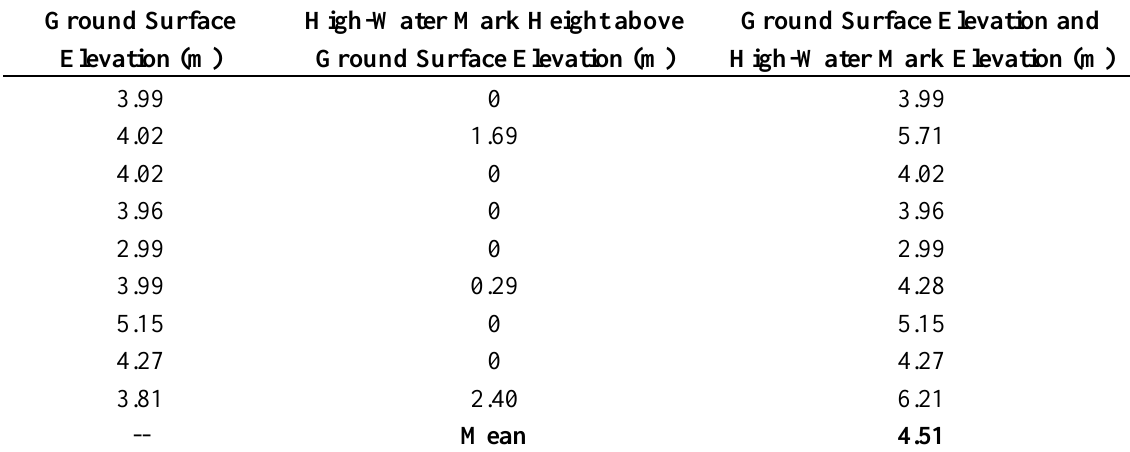
Figure 2. U.S. Geological Survey high-water marks collected in cooperation with the Federal Emergency Management Agency on the southern part of Staten Island, New York. We used the mean of GPS survey elevation values and high-water mark height above ground values to derive a single-value surface method inundation value. Also, see Table 1. Table 1. Mean of U.S. Geological Survey GPS ground survey elevations and high-water marks in the study area. Also, see Figure